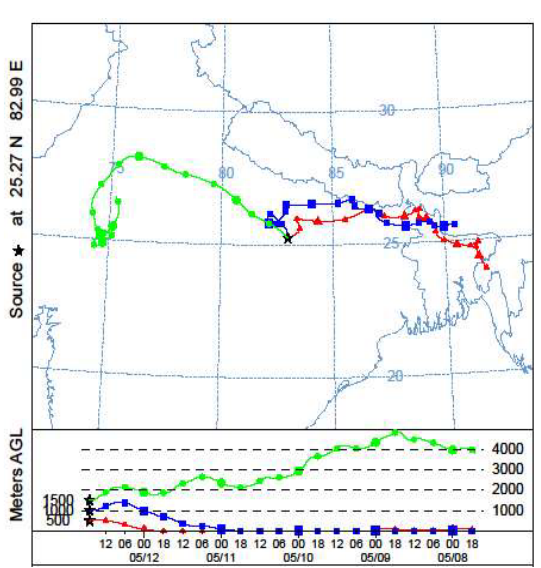
Figure 4: The Five days back trajectories using HYSPLIT model over Varanasi for 12 May 2017 with huge aerosol